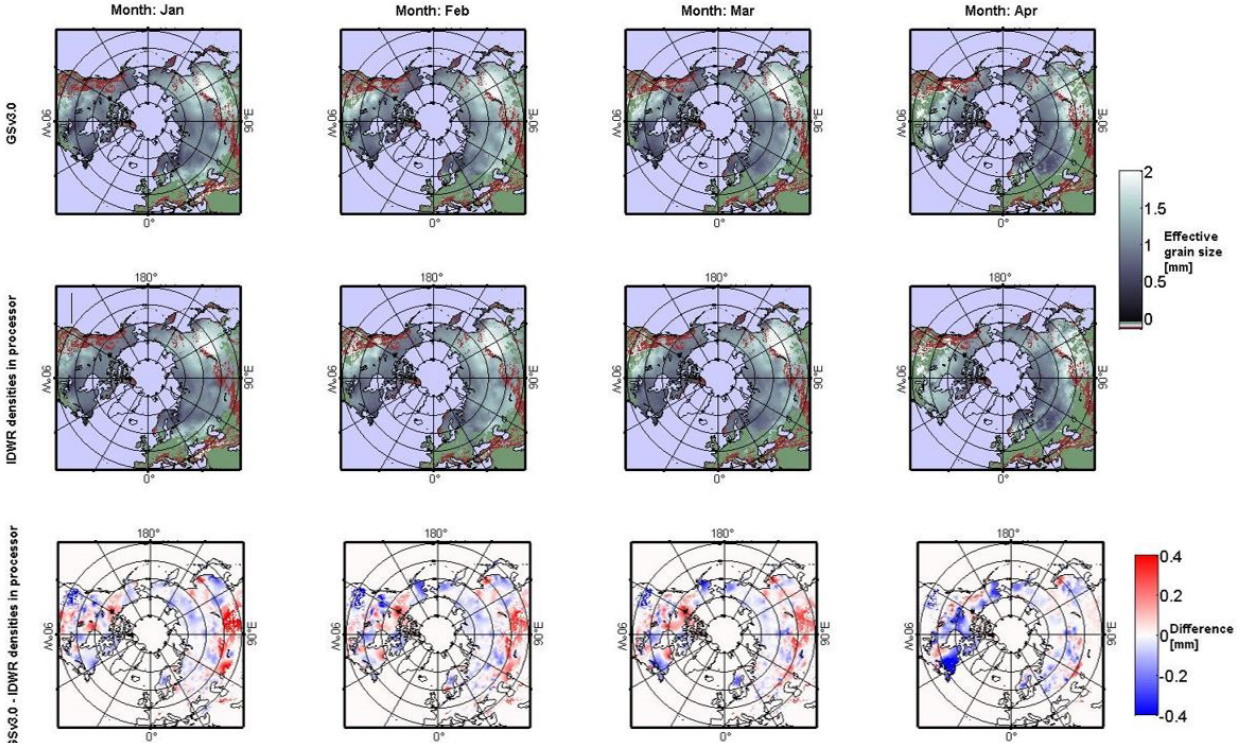
Figure 5. Monthly average effective snow grain sizes for GSv3.0 and IDWR densities in the SWE processor are shown in the top and middle row, respectively. Effective snow grain sizes are shown for January, February, March, and April 2005. Bottom row shows the differences in average effective snow grain sizes between GSv3.0 and IDWR densities in the